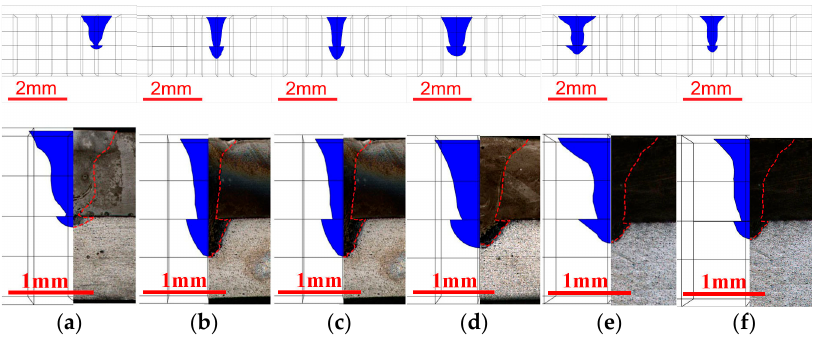
Figure 6. Comparison of simulated molten pool morphology and actual one. ( a ) The fi rst weld seam; ( b ) the second weld seam with weld spacing of 0 mm; ( c ) the second weld seam with weld spacing of 0.5 mm; ( d ) the second weld seam with weld spacing of 1.0 mm; ( e ) the second weld seam